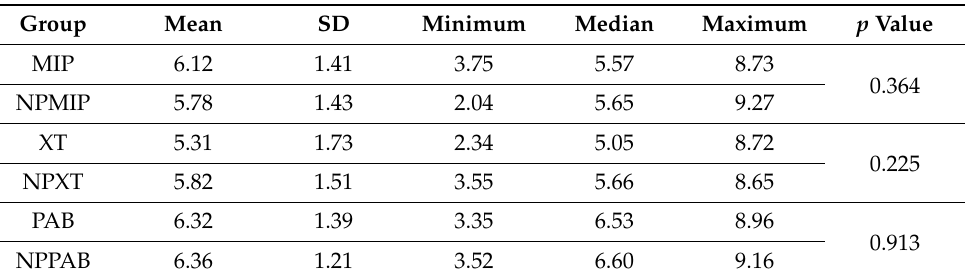
Table 1. SBS (MPa) of the bracket to enamel in the groups (n = 30/group).